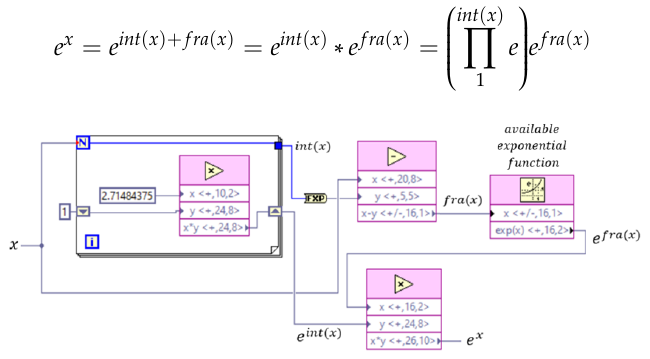
Figure 8. Algorithm to calculate power of e less than − 1.